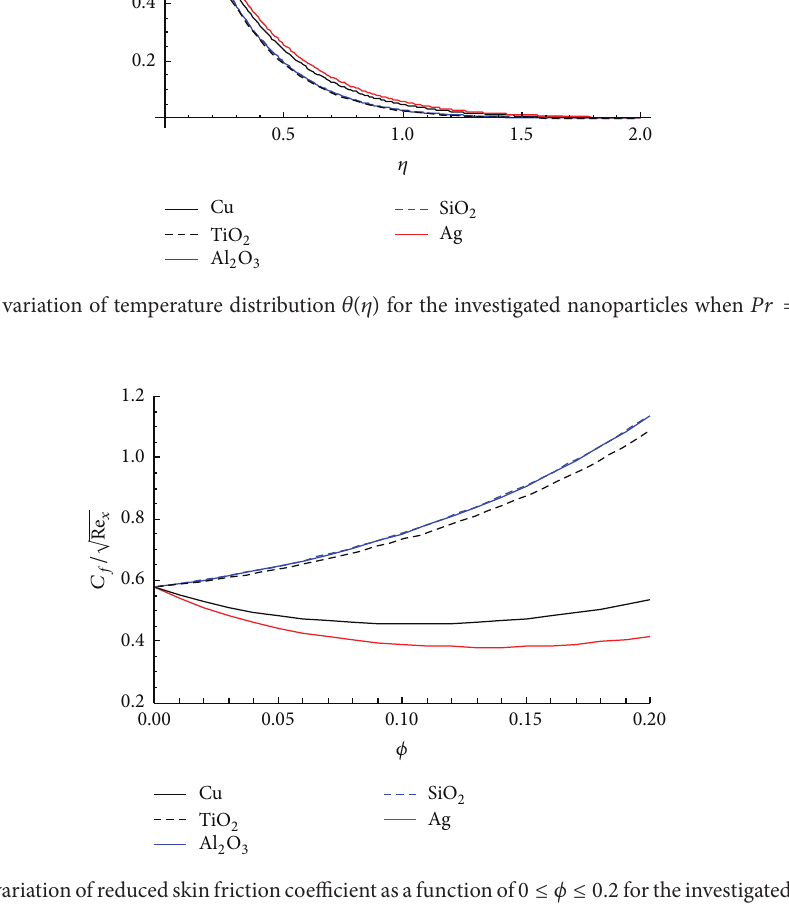
Figure18:Comparingthevariationofreducedskinfrictioncoefficientasafunctionof 0 ≤ 𝜙 ≤ 0.2 fortheinvestigatednanoparticles 𝑃𝑟 = 6.2 , = 1 , 𝛿 = −1 , and 𝑠 = 0.5 . 𝛿 1 2